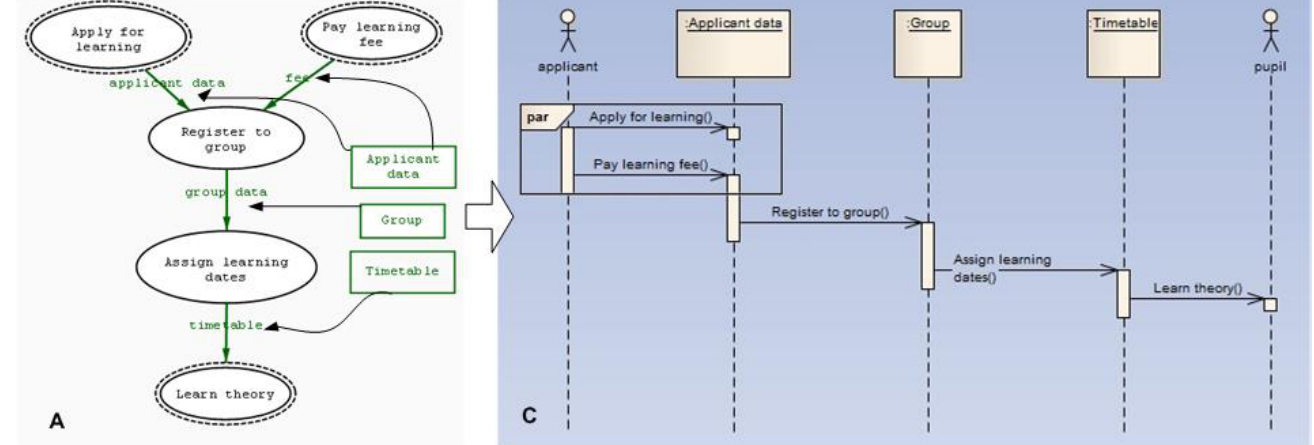
Fig. 5. Application of the transformation and layout